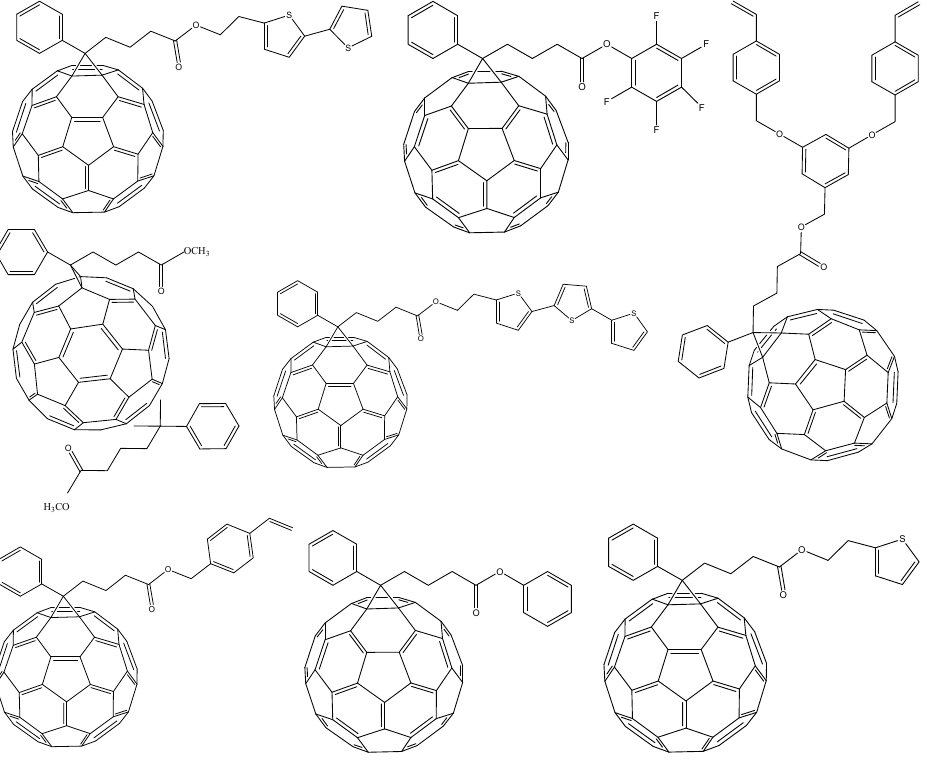
Figure 5. Representative fullerene derivatives as morphological control agents.